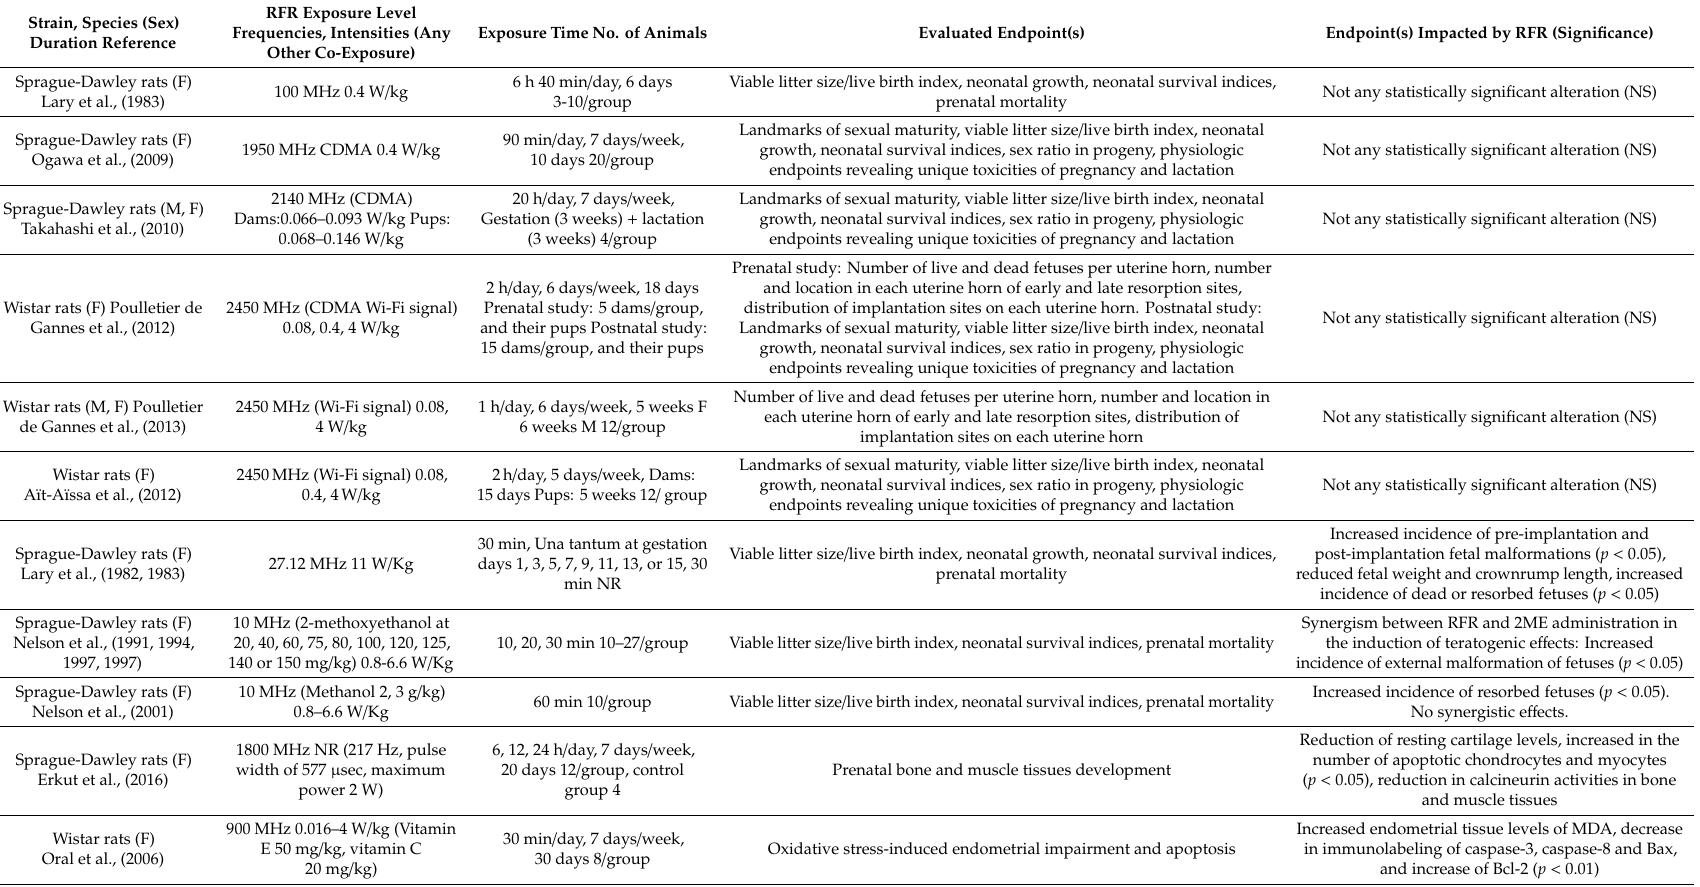
Table 7. Female reproductive studies and other reproductive / developmental endpoints in rats exposed to